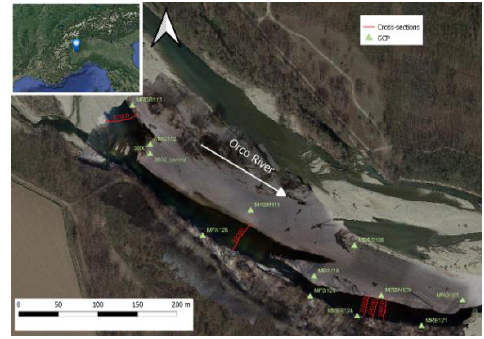
Figure 5. Orco river orthomosaic map. The red lines indicate the cross-sections measured with GNSS, while the green triangles are the GCP used in the photogrammetric procedure.